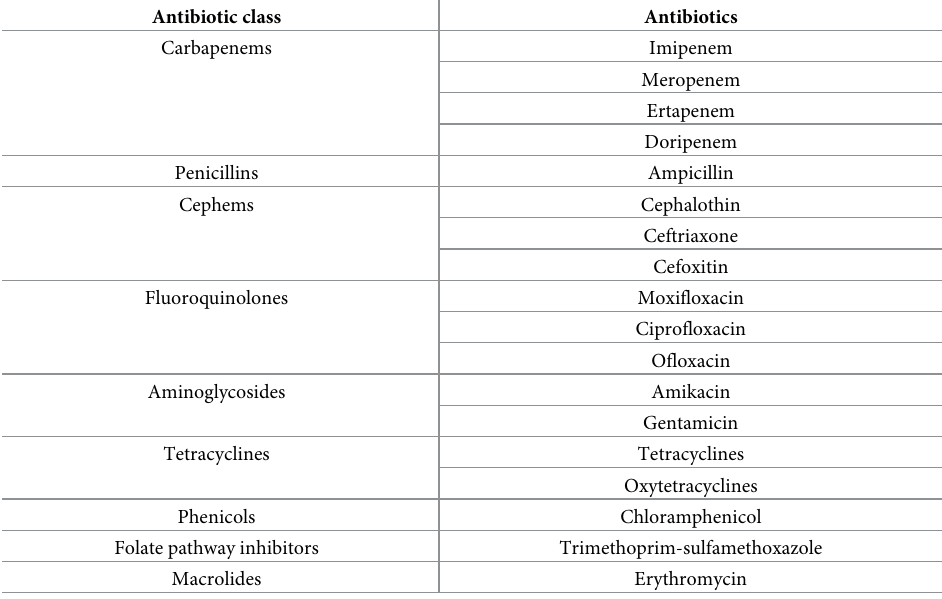
Table 1. Antibiotics used in the Kirby-Bauer Disk Diffusion